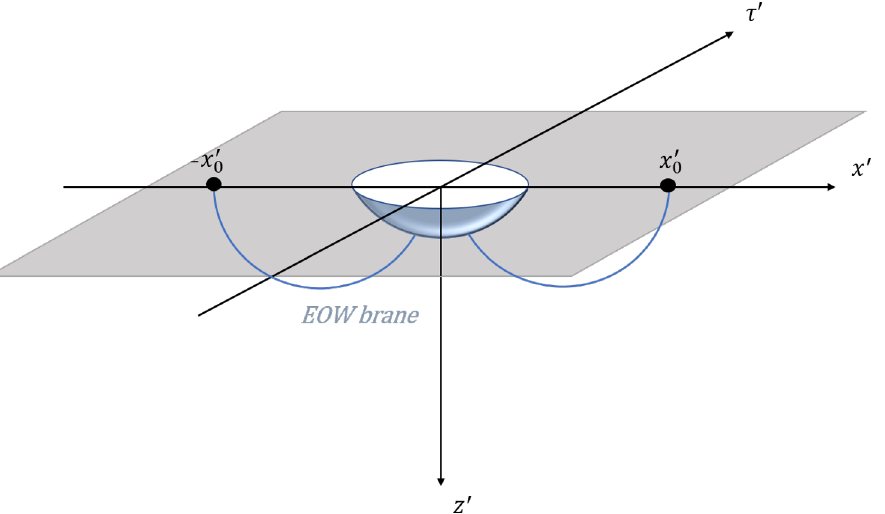
Figure 8 . Connected phase of extremal surface.